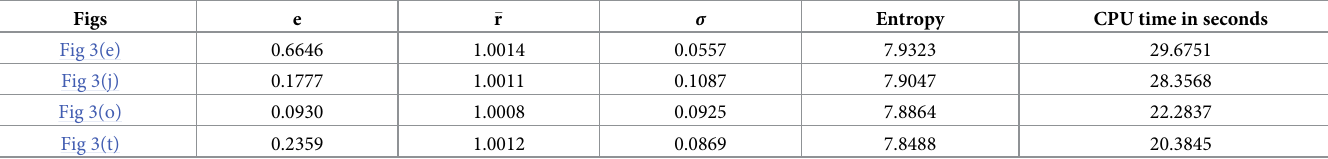
Table 2. Quantitative results of the model-M3 under e, � r , σ , entropy measure and CPU time for the de-hazed images of synthetic road scene images under heteroge- neous fog. Figs